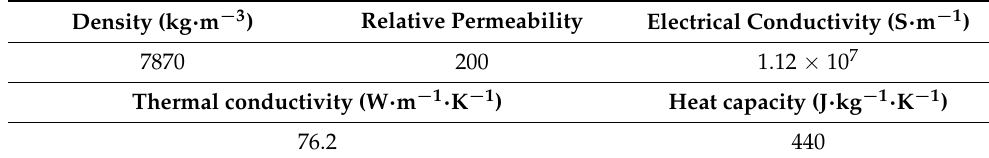
Table 2. The material properties of carbon steel. Table 3. The material properties of copper.